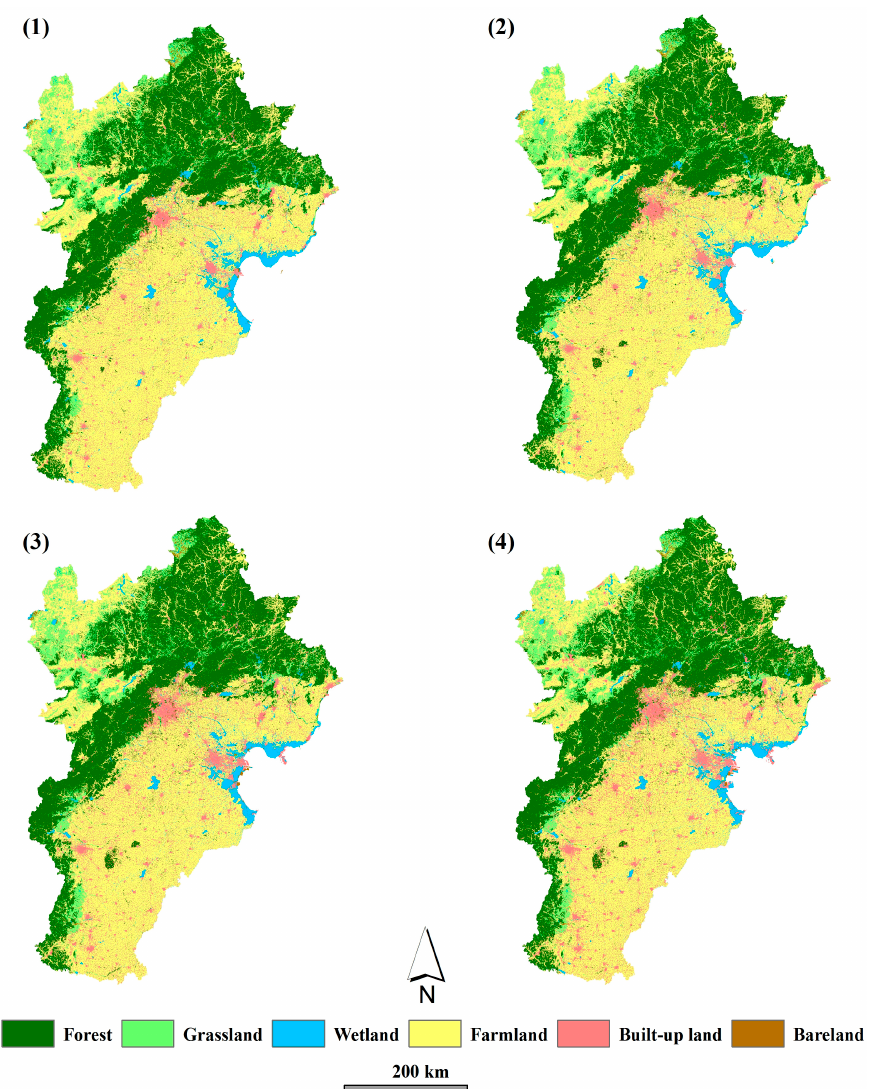
Figure 2. The land cover details of the BTH region in ( 1 ) 2000, ( 2 ) 2005, ( 3 ) 2010, and ( 4 )